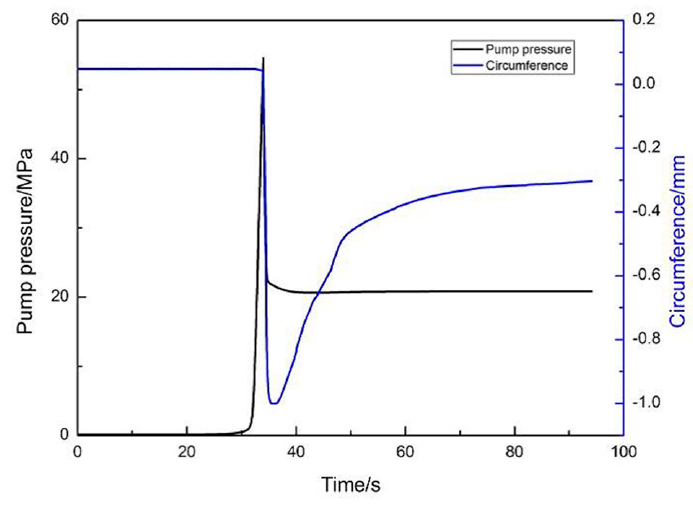
Figure 2. Pump pressure and circumference development during the fracturing process.